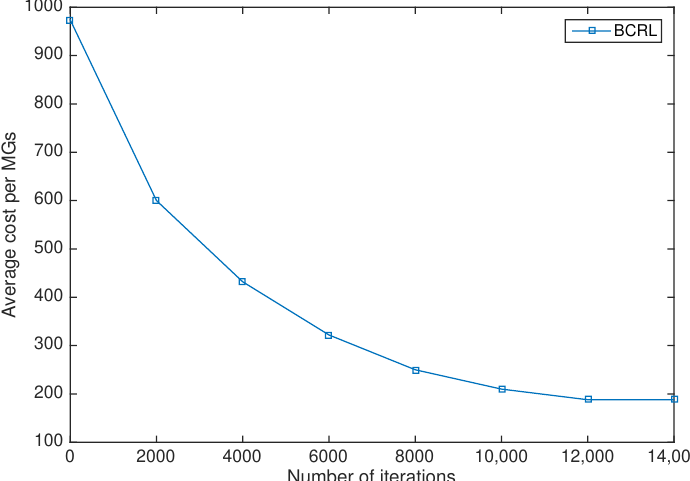
Figure 8. Convergence of the average cost per user versus the number of iteration for BCRL.